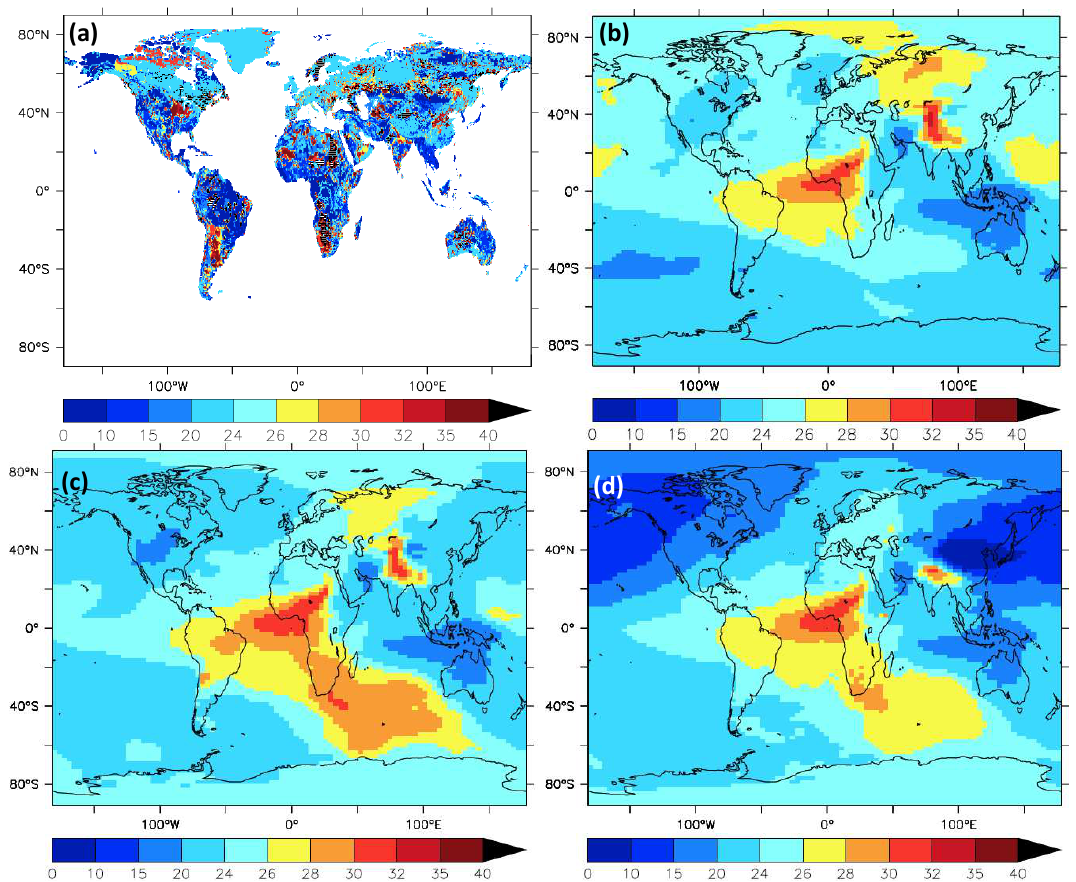
Fig. 11. Comparison of illite (mass%) (a) in soil; (b) airbone, CASE 0; (c) airborne CASE 1; (d) airborne CASE